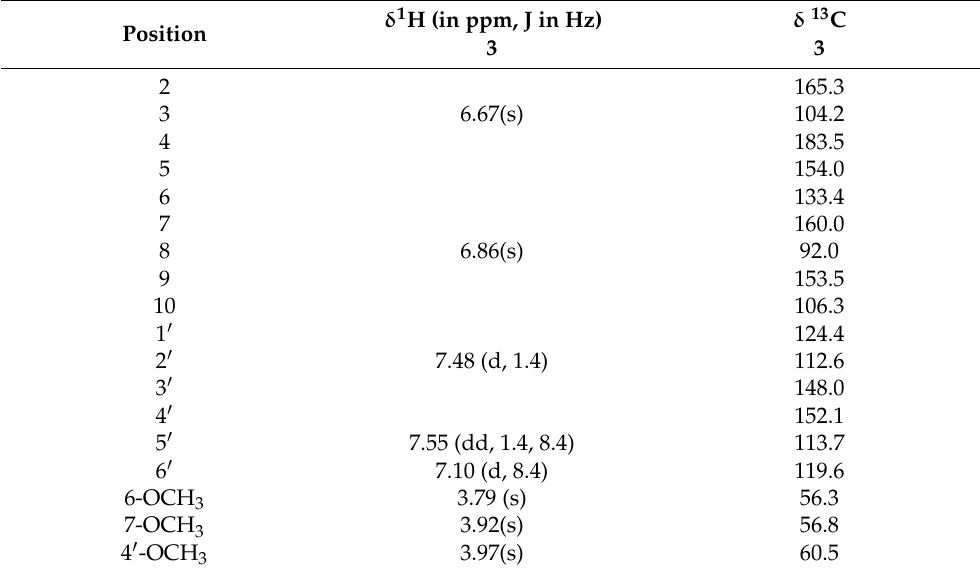
Figure 1. Chemical structures of compounds isolated from the SlD-3 fraction. Table 2. NMR spectroscopic data for eupatorin ( 3 , 600 MHz, CD 3 COCD 3 , δ ppm, J in